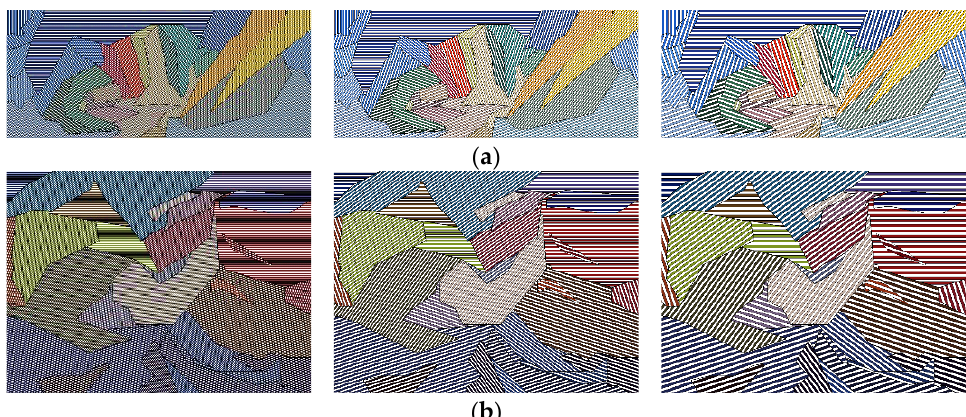
Figure 10. Two examples of the results of region direction finding and stripe creation. ( a ) Three results of different abstractions of the image by Giacomo Balla shown in Figure 9a. ( b ) Three results of different abstractions of the image by Giacomo Balla shown in Figure 9d.